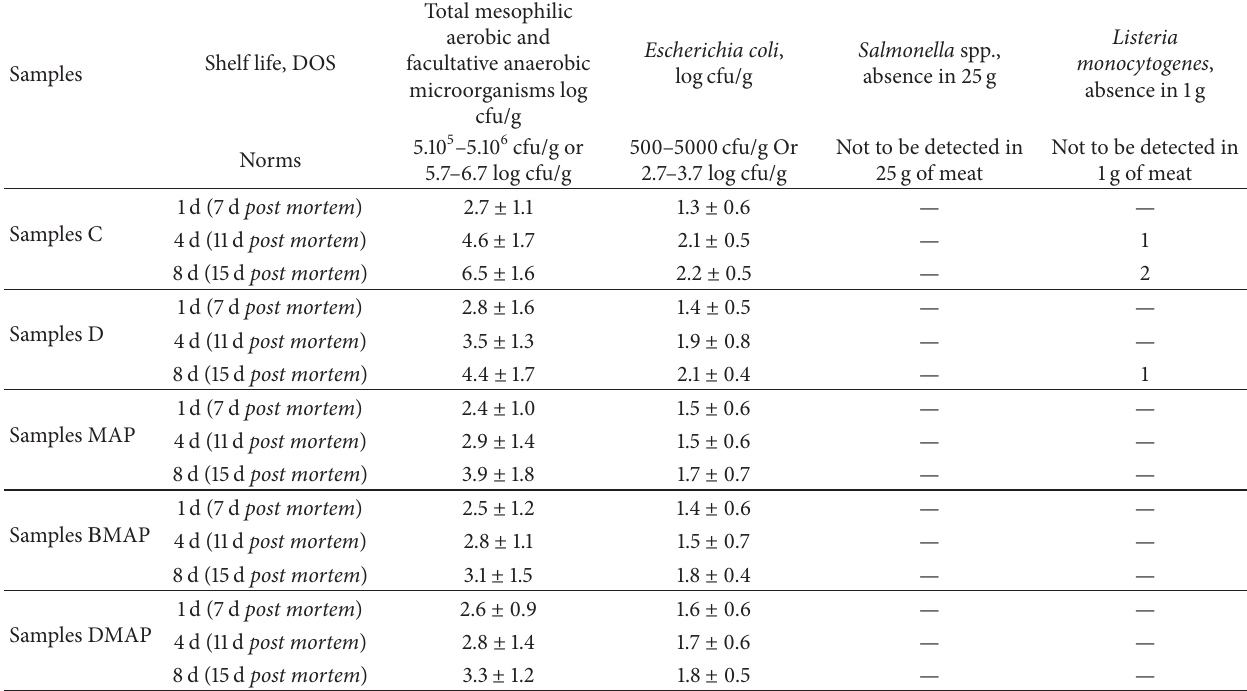
Table 3: Microbiological status of veal samples during 8 DOS (15d post mortem ) at 0 ± 0.5 ∘